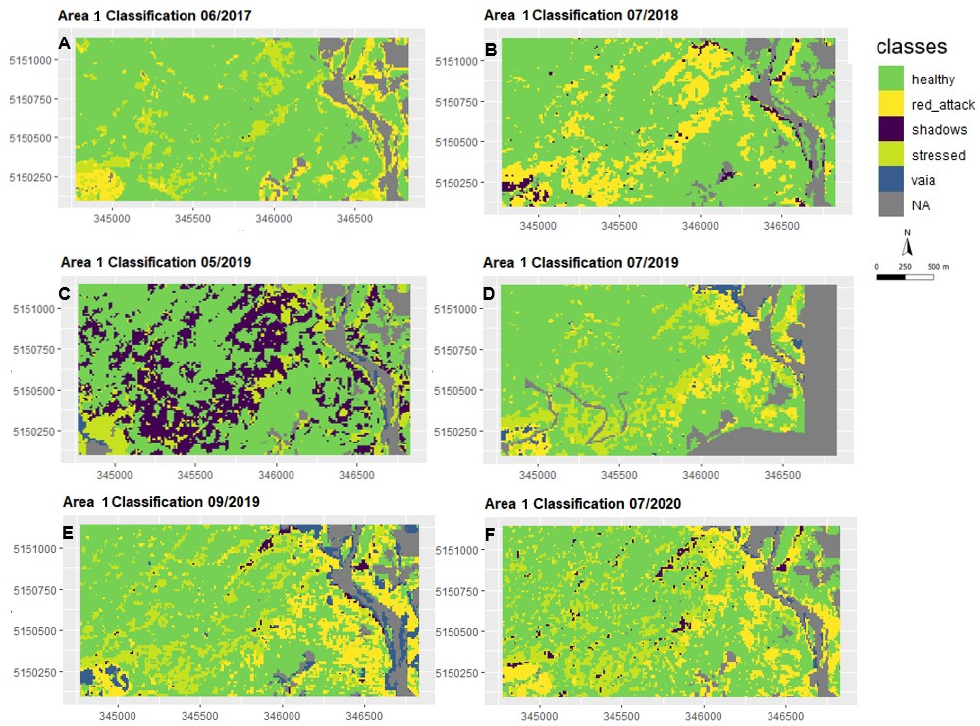
Figure 9. Classification maps of cropped area 1 from 2017 to 2020 (June 2017 ( A ), July 2018 ( B ), May 2019 ( C ), July 2019 ( D ), September 2019 ( E ) and July 2020 ( F ) according to forest cover classes (“healthy”, “red_attack”, “shadows”, “stressed” and “vaia”). Reference System: WGS84-UTM33N. As in cropped area nr. 1, the forest stands of cropped area 2 (Figure 10) also already showed conditions of stress and the “red_attack” stage in June 2017 (Figure 10A). The sites detected as stressed in June 2017 (Figure 10A) were classified as “red_attack” stage stands in the classification map of July 2018 (Figure 10B). Some of the canopies detected as stressed in May 2019 (Figure 10C) turned into the “red_attack” stage class as early as in July 2019 (Figure 10D), while most of them changed class in September 2019 (Figure 10E) or even in the following season (Figure 10F). Orthophoto details from 2020 showed that several forest stands located near wind-felled areas (top-right corner of the orthophoto details) were classified as stressed in 2019 (Figure 10C–E) and turned into the “red_attack” stage in July 2020 (Figure 10F). According to the classification results, bark beetle infesta- tions generally intensified after the Vaia storm, especially in 2020, two years after the event (Figure 10F), and spread in proximity to wind-felled patches (Figure 10E).